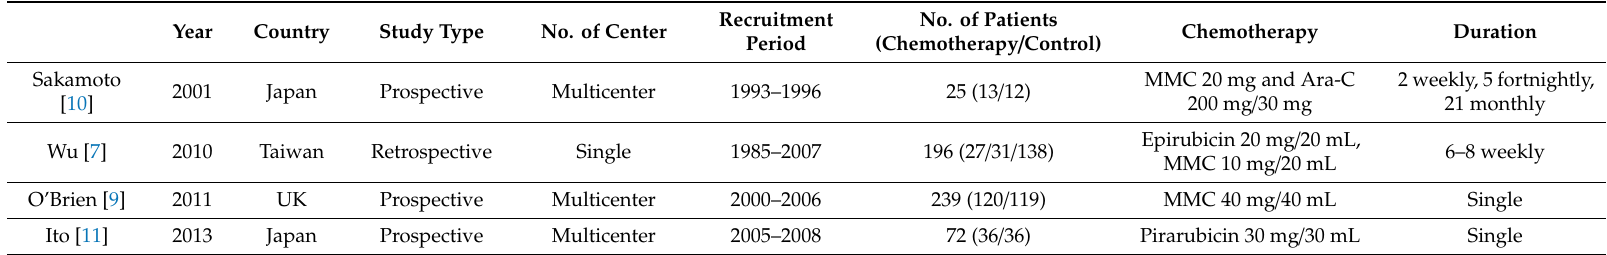
Table 1. Characteristics of eligible studies.